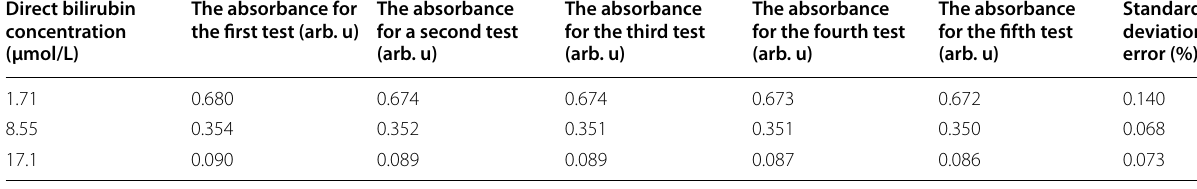
Table 1 The reproducibility measurement of the blue Mini‑LEDs MOD Direct bilirubin concentration (μmol/L)